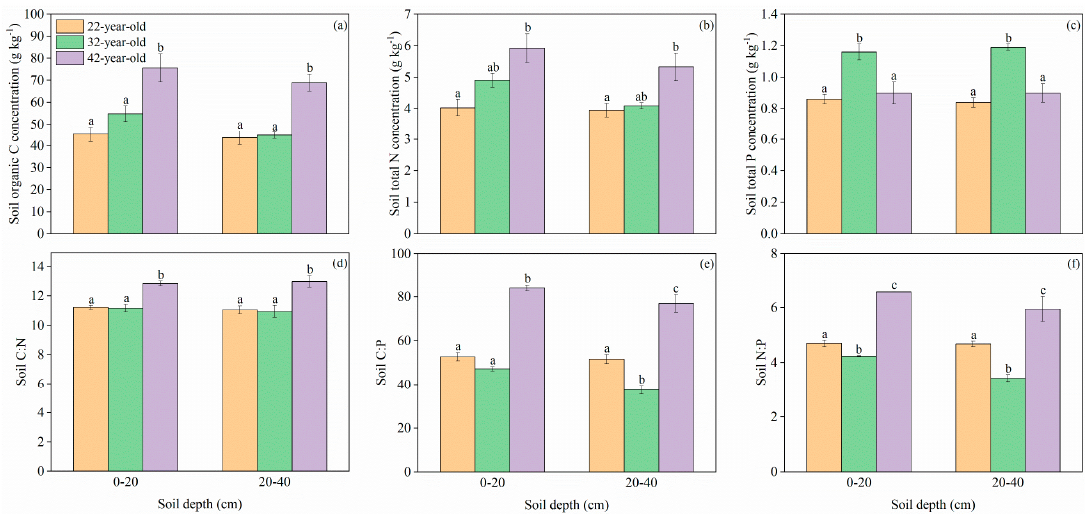
Figure 1. ( a ) C concentration, ( b ) N concentration, ( c ) P concentration, ( d ) C:N, ( e ) C:P and ( f ) N:P in the mineral soil of three di ff erent aged P. asperata plantations. Di ff erent lowercase letters indicate a significant di ff erence between di ff erent aged stands at the same soil horizon ( p < 0.05).